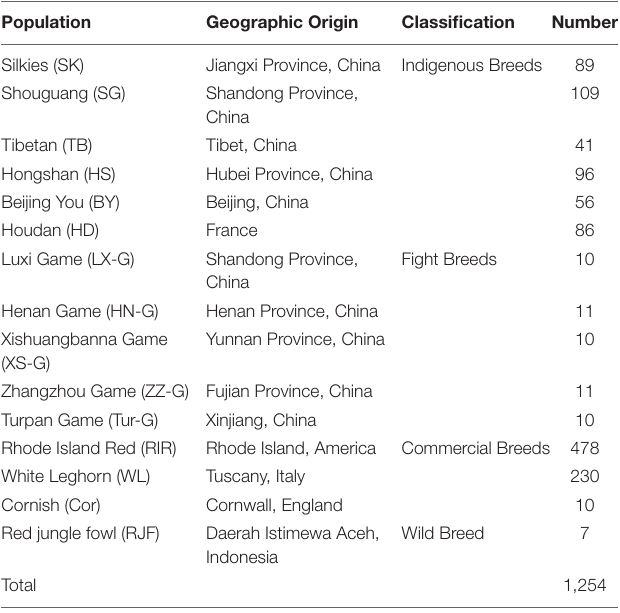
TABLE 1 | Categories of chicken